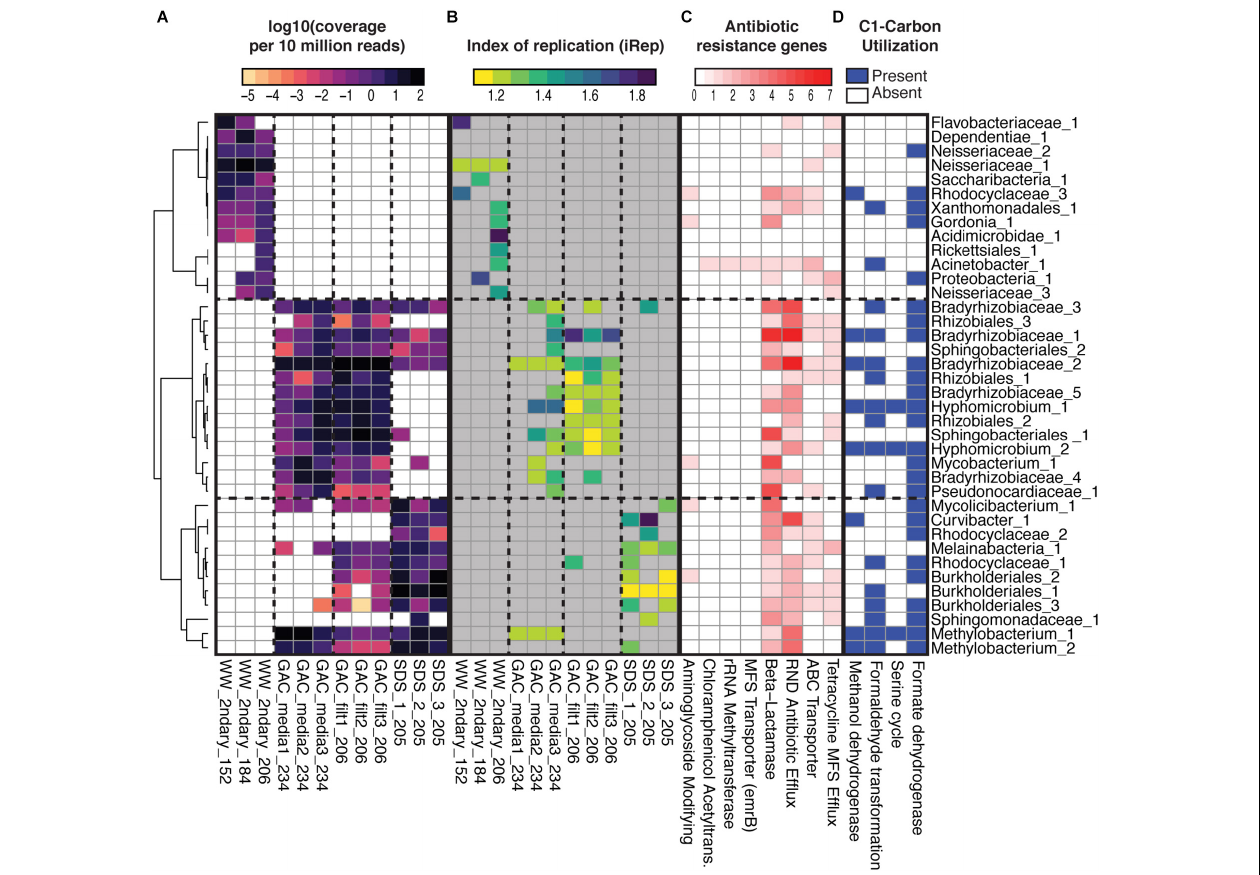
FIGURE 6 | Metagenome assembled genomes (MAGs) relative abundance, indices of replication, ARG contents, and selected C1-compound utilization. (A) Relative abundance of 38 MAGs (row) across the 12 samples (columns) based on stringent read mapping. Cell color indicates log-10 normalized coverage per 10 million reads, and white indicates non-detection (detection threshold required at least 1 × coverage across > 5% of genome length). MAGs are named based on their placement in a concatenated ribosomal protein tree ( Supplementary Figure S6 ), with numerical identifiers added for uniqueness when necessary. Hierarchical clustering of MAGs ( y -axis) is based on a distance matrix calculated from Spearman’s rho. Sample names are based on location in treatment train, secondary wastewater (“WW_2ndary”), media from three parallel GAC columns (“GAC_media”), filtrate from three parallel GAC columns (GAC_filt), and bulk water from three parallel SDS (“SDS”). (B) iRep values for each MAG in each sample. Gray indicates no data where requirements for calculating iRep were not met. (C) Counts of ARGs by category based on ResFams. (D) Presence of selected pathways for C1-carbon utilization in each MAG, based on annotations of a subset of